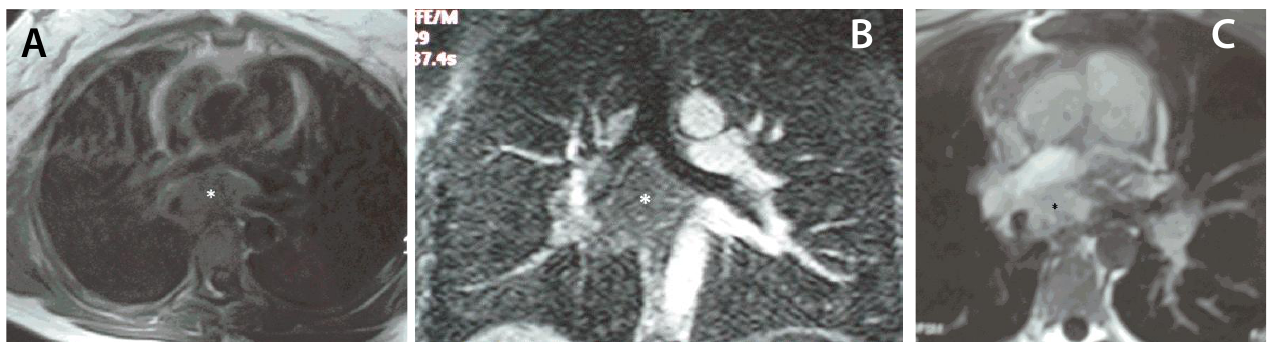
Fig. 3 – A: Axial T1-weighted image. The mass is almost isointense to the thoracic muscles (white asterisk). B: Coronal gradient-echo T2 image. The mass extends upward to the subcarinal region. The lesion exhibits a heterogeneous hypointensity (white asterisk), consistent with the presence of fibrous component. C: Axial T1-weighted image, post-gadolinium image. The mass (black asterisk) shows contrast uptake, more homogeneous in its anterior part. Note that the uptake is less homogeneous in its posterior part. Contrast uptake may represent areas with active inflammation.